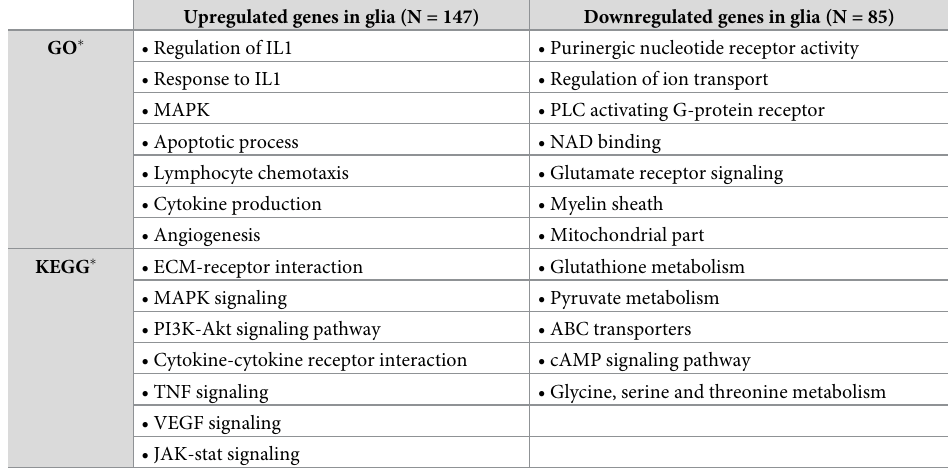
Table 4. Relevant GO and KEGG terms of up- and downregulated genes in glia at 24 hours post injection in the intracortical kainic acid model of mTLE.